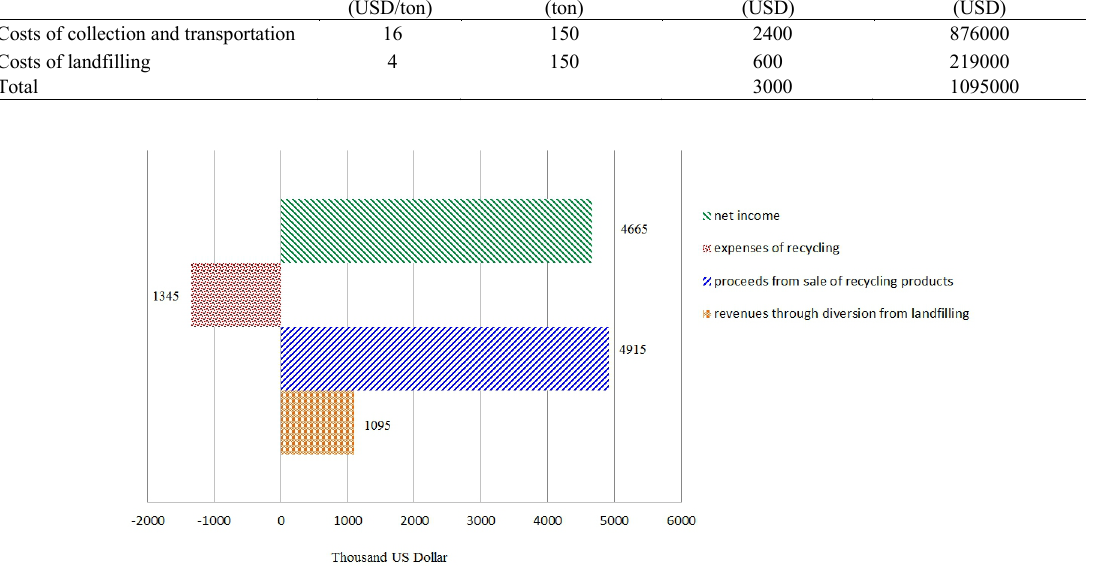
Fig. 2: Overview of total yearly costs, revenues and net income of